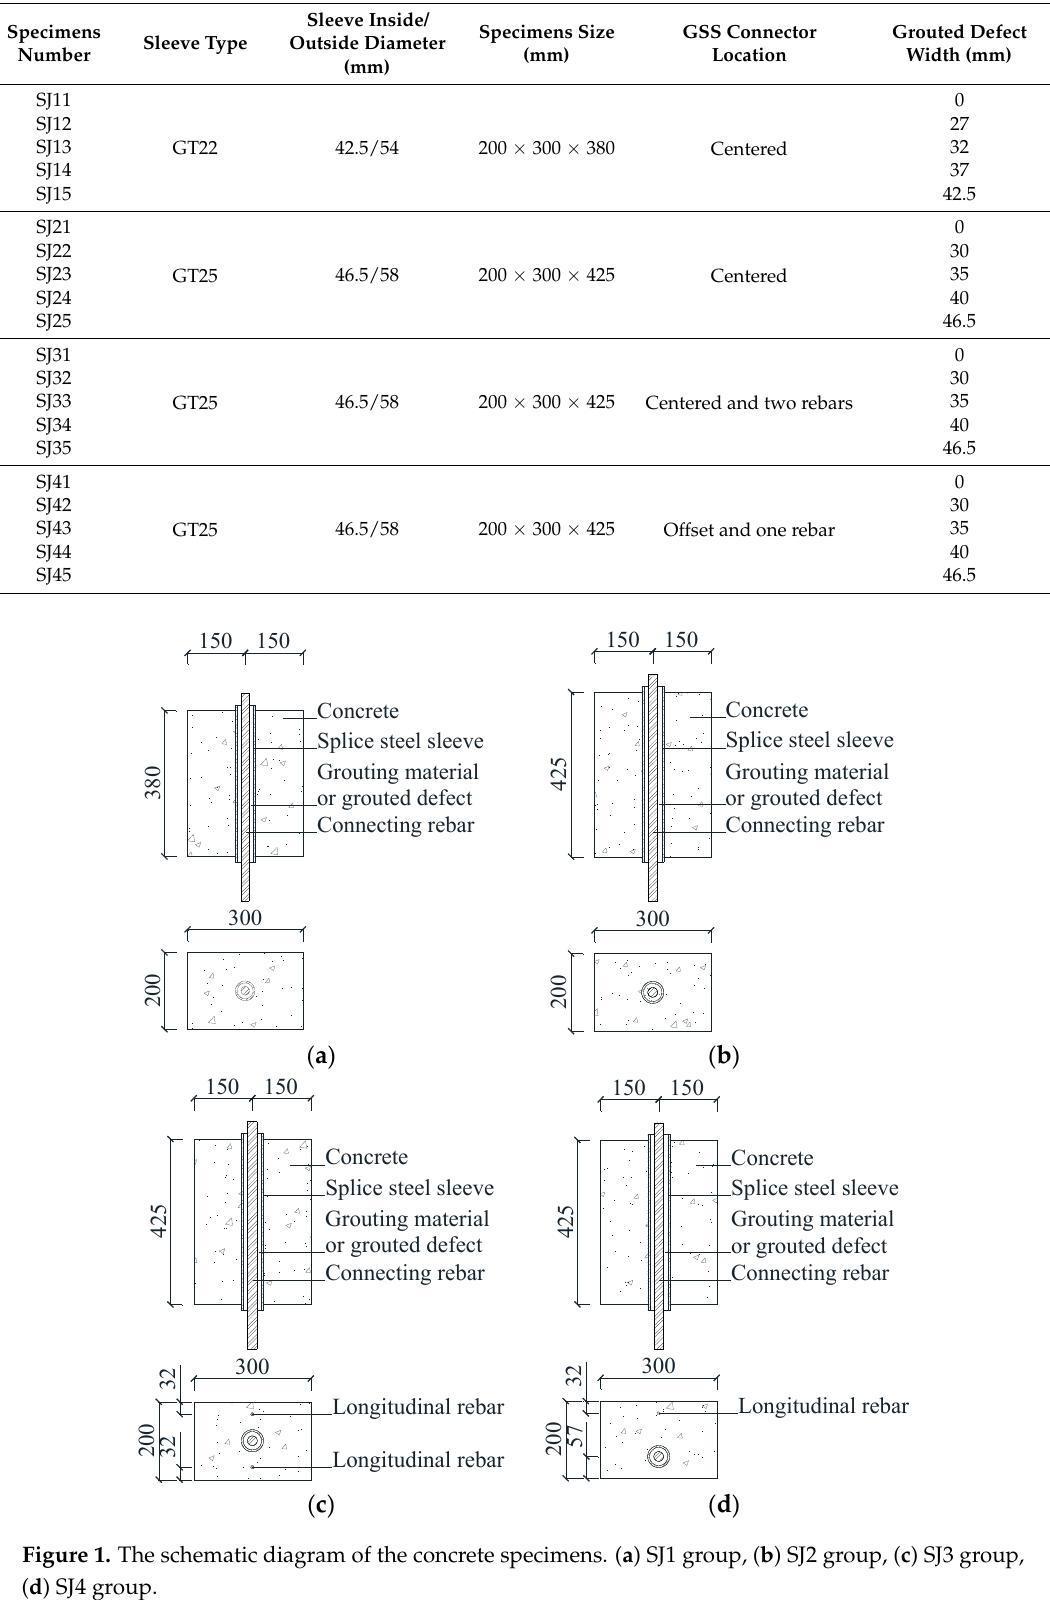
Table 1. The sizes and the defect settings of the specimens.